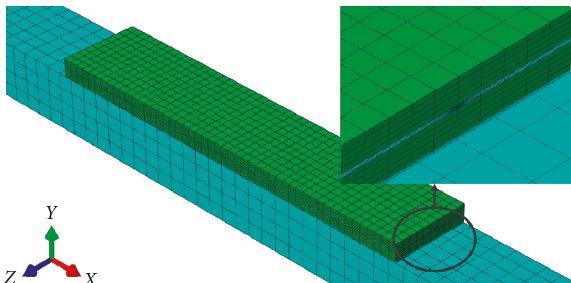
Figure 3: Finite element model corresponding to the scheme in Figure